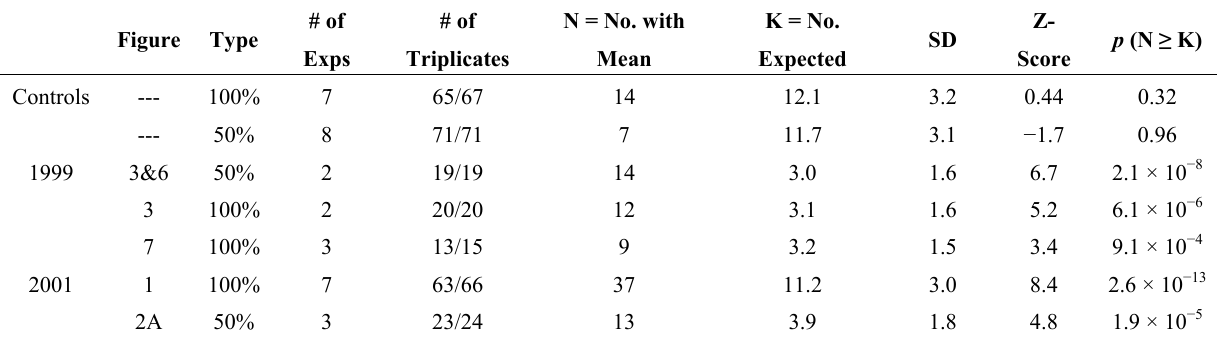
Table 2. Analysis of the frequency of the occurrence of the rounded mean in the triplicate samples of colony counts. Column 6 is the number N of triplicate samples that contain the rounded mean of the three counts. Column 7 is the number K that is expected based on our model. The z -scores incorporate the correction for continuity. The numerator in Column 5 is the number of qualifying triplicates (triplicates for which the gap (c-a) is greater than two). The denominator in Column 5 is the total number of